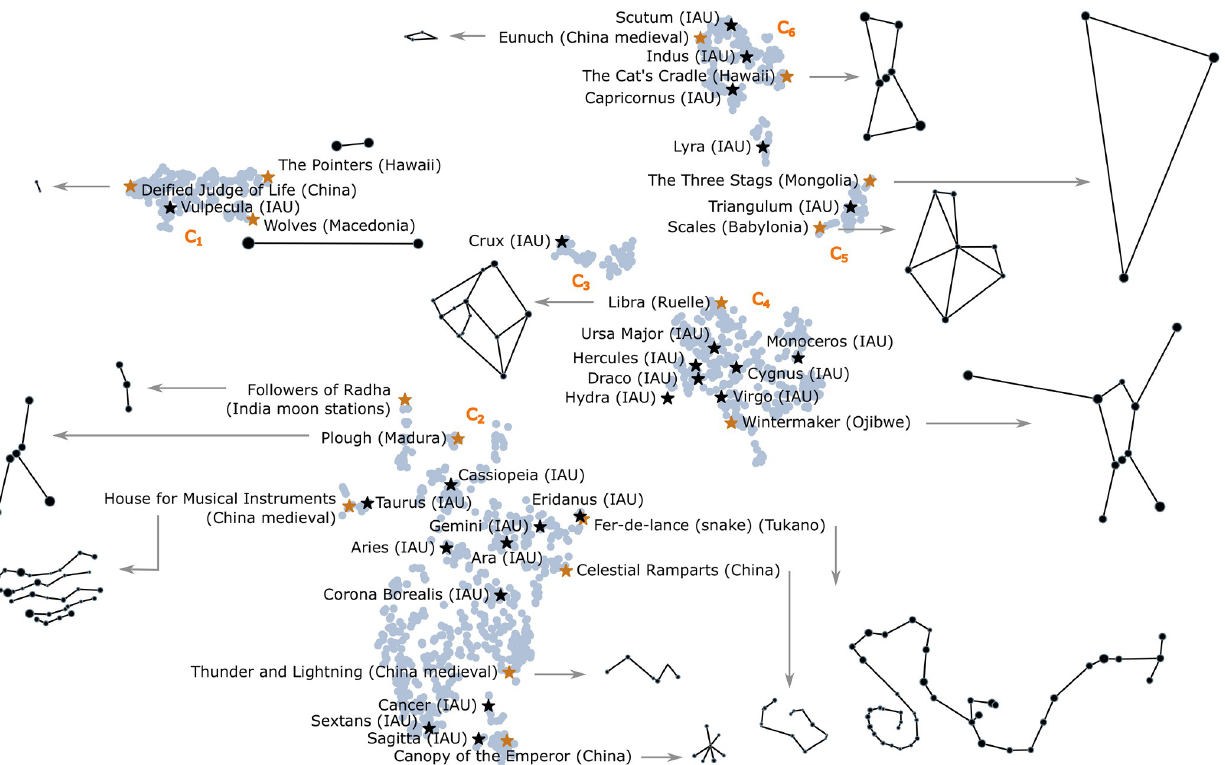
Fig 5. Examples of constellations over the embedding. In the background, in light blue, the embedding of all constellations, the same as in Fig 4. In the foreground, we show example constellations: (1) black markers for IAU constellations [11]; (2) orange markers for other cultures. cultures, are embedded, in Fig 5: black stars mark some of the IAU constellations [11], while orange ones mark some constellations from other cultures. Their line figures are shown to